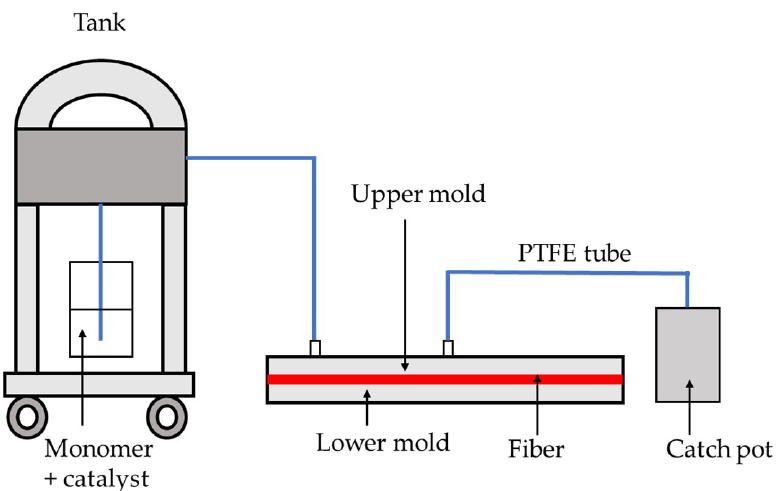
Figure 1. Resin transfer molding (RMT) device.